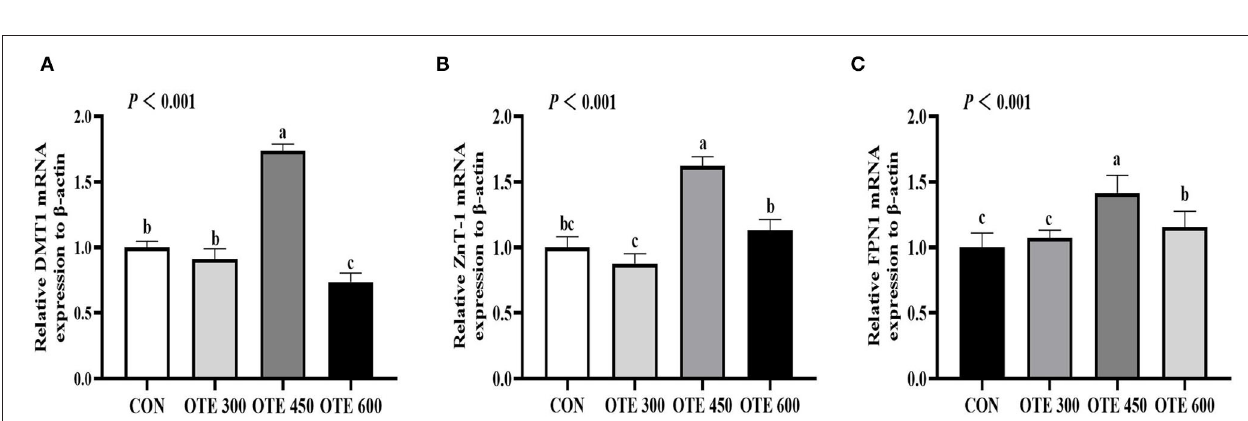
FIGURE 5 | Effects of organic trace elements on messenger RNA (mRNA) expression of duodenal trace element transporter in late-phase laying hens. DMT1 (A) , divalent metal transporter 1; ZnT-1 (B) , zinc transporter 1; and FPN1 (C) , ferroportin 1. Different letters represent significant differences ( p <